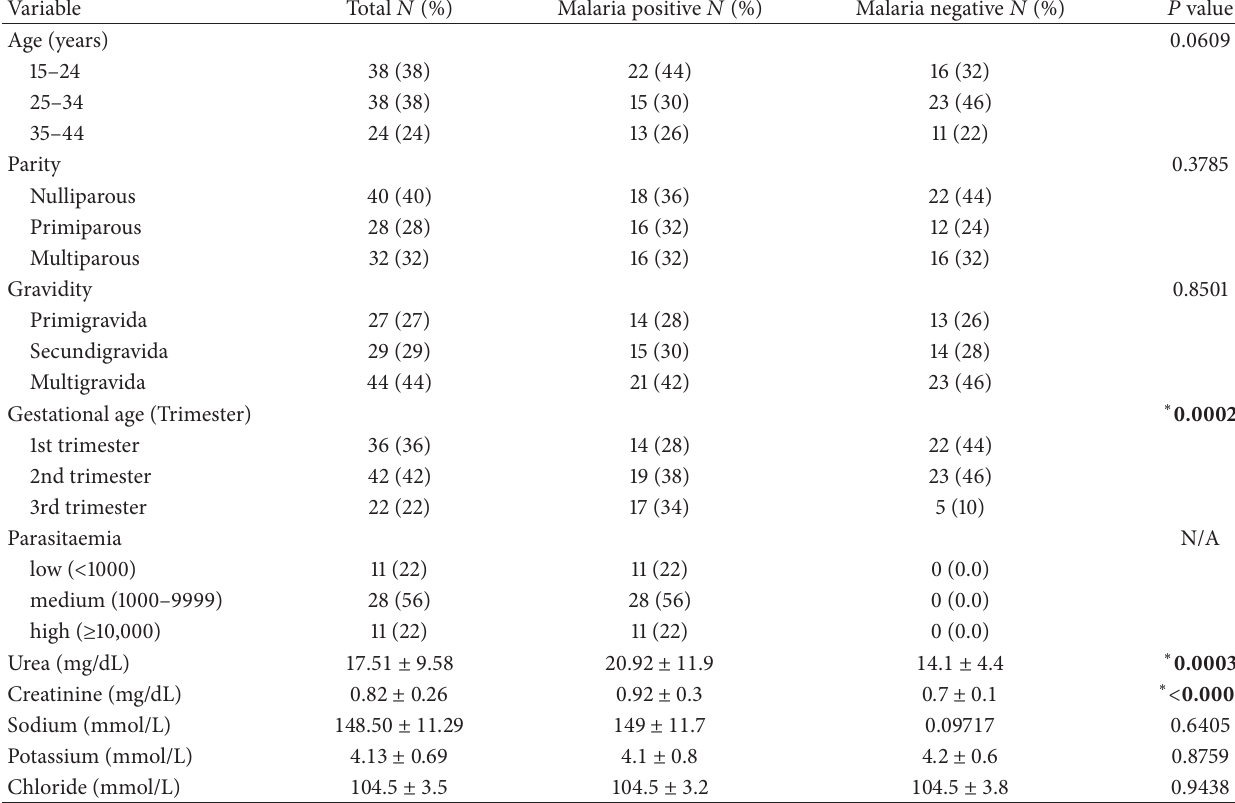
Table 1: Demographic and biochemical characteristics of study participants.